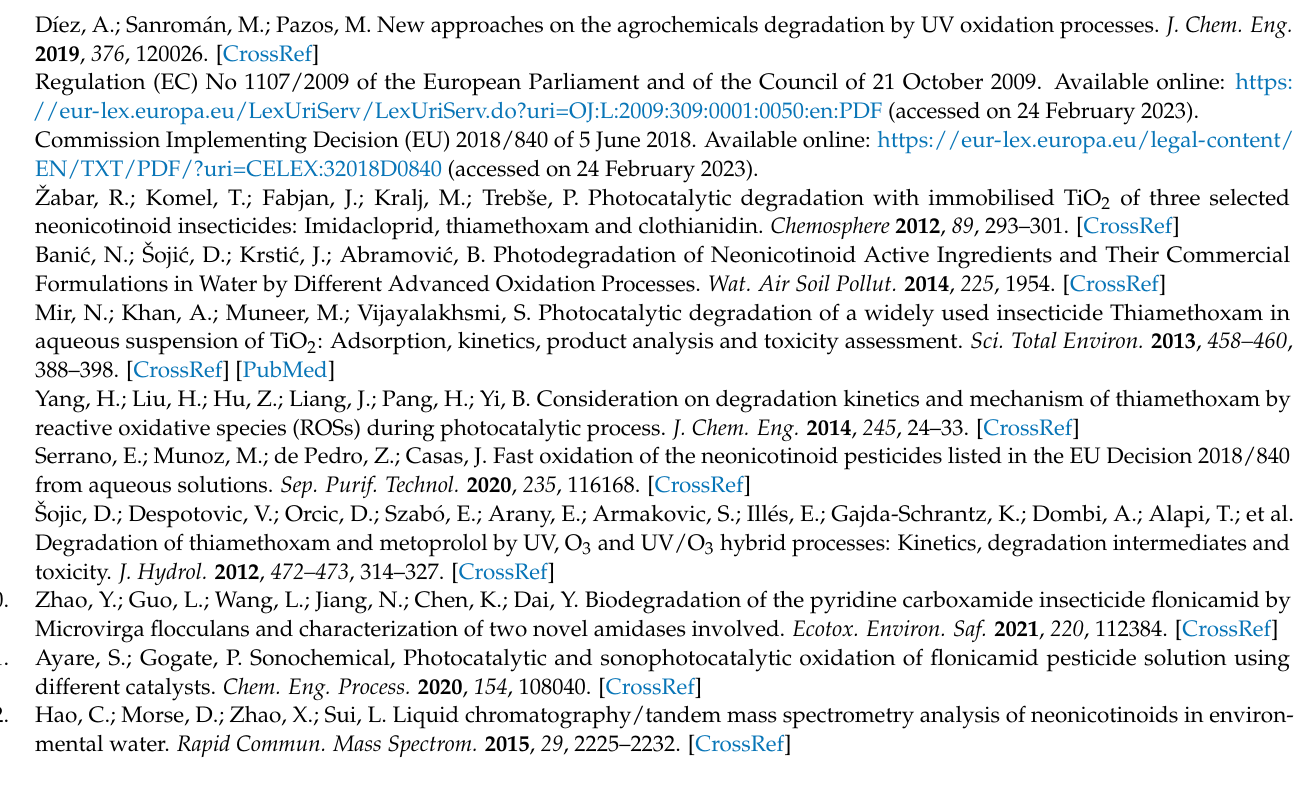
for the pesticides’ detection. Table S2: Chromatography parameters with time for the detection of FND metabolites. Table S3: Overview of the LCMS-MS parameters for the analytes investigated. Figure S1: Degradation kinetics of photocatalytic degradation of (a) Linear transform ln(C 0 /C) = f(t) of thiamethoxam (TMX) and (b) flonicamid (FND) using titania P25 at the studied concentrations (UV-A irradiation, 0.1 g/L TiO 2 , natural pH, 25 ◦ C); Effect of the concentration on the initial degradation rate of both pesticides (c). Figure S2: Total mineralization efficiency of thiamethoxam (TMX) and flonicamid (FND) during the photocatalytic process (UV-A irradiation, 0.1 g/L P25 TiO 2 , natural